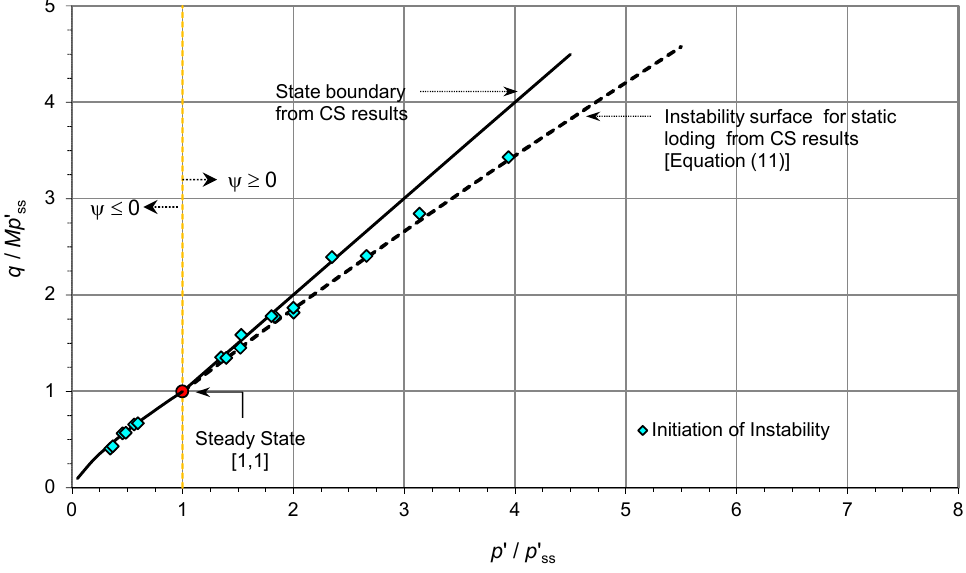
Figure 14. Instability region in normalized space from the CS test results.